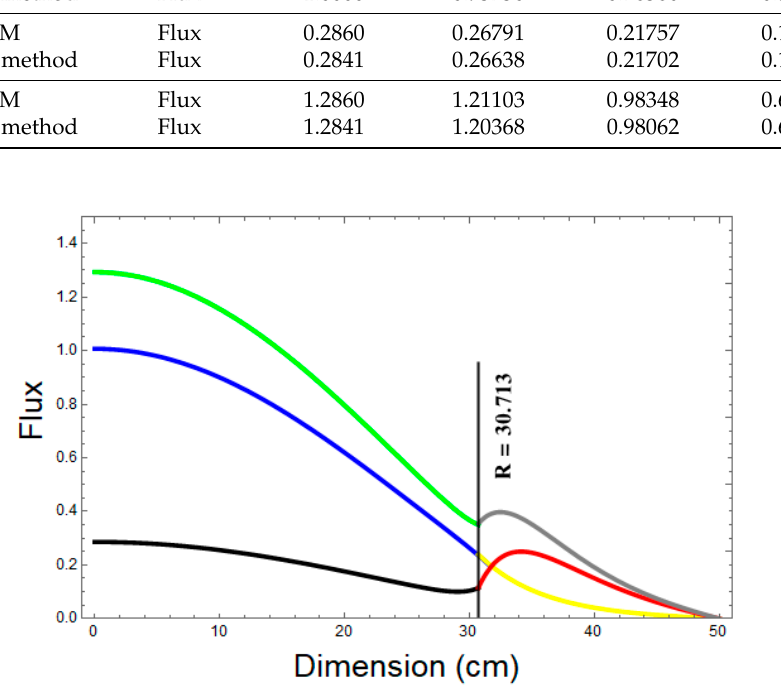
Figure 4. Flux distribution in the core and reflected parts of two-group reflected reactor. Black, ∅ 1 c ( r ) ; Blue, ∅ 2 c ( r ) ; Red, ∅ 1 r ( r ) ; Yellow, ∅ 2 r ( r ) ; Green, ∅ tot . c ( r ) ; Gray, ∅ tot . r ( r )